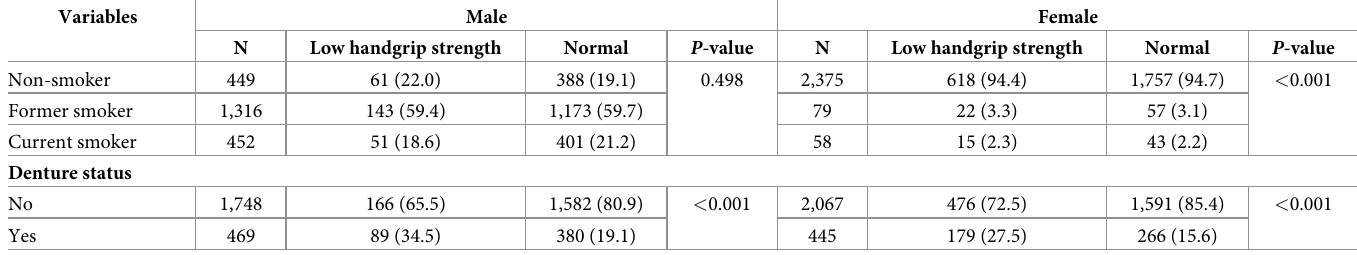
The mean number of natural teeth and POPs according to gender and age group are pre- sented in Fig 1. In males, the mean number of natural teeth was 21.0 ± 0.29 in participants in their 60s, 17.1 ± 0.39 in their 70s, and 13.4 ± 0.76 in their 80s or older. In females, the mean number of natural teeth was 22.6 ± 0.21 in those in their 60s, 18.1 ± 0.33 in their 70s, and 11.7 ± 0.70 in their 80s or older. The mean number of POPs in males was 6.3 ± 0.15 in those in their 60s, 4.3 ± 0.19 in their 70s, and 2.7 ± 0.32 in their 80s or older. In females, the mean num- ber of POPs was 7.0 ± 0.14 in their 60s, 4.5 ± 0.16 in their 70s, and 2.0 ± 0.22 in their 80s or older. The mean number of natural teeth and POPs decreased significantly as age increased in both males and females (p < 0.001). The proportion of those with low handgrip strength according to the number of POPs and the presence of a hopeless tooth are presented in Fig 2. With the same number of POPs, the presence of a hopeless tooth increased the proportion of those with low handgrip strength in both males and females. In males, when the POPs score was 12, the low handgrip strength ratio was 4.5% without hopeless teeth, but increased to 20.3% in the presence of a hopeless tooth. In those with 8–11 POPs, the low handgrip strength ratio was 7.7% without hopeless teeth, and 14.2% in the presence of a hopeless tooth. In those with 0–7 POPs, the low handgrip